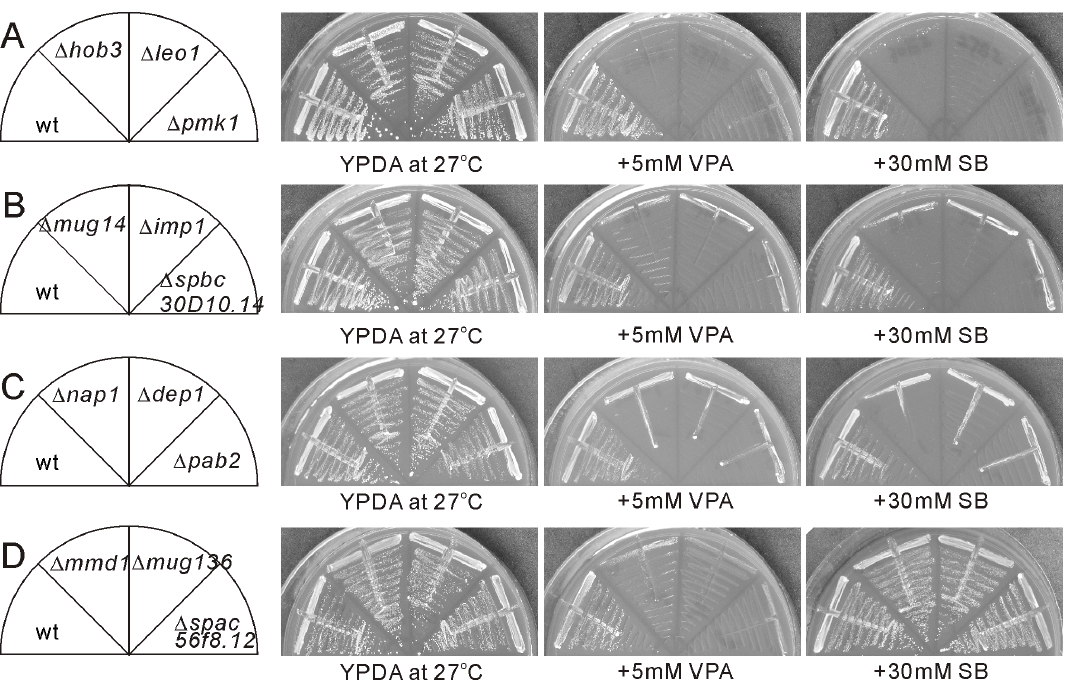
Figure 1. Representative growth pattern of the S.pombe deletion mutants in the presence of VPA or SB. The log-phase wild-type (wt) and deletion cells as indicated were streaked onto YPDA plates with or without 5 mM VPA or 30 mM SB, and incubated at 27 u C for 6 days.